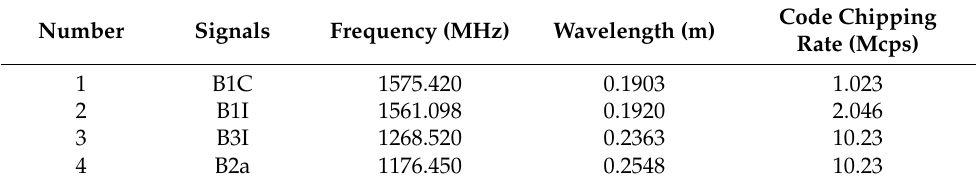
Table 1. The frequency and wavelength information of BDS-3 four-frequency